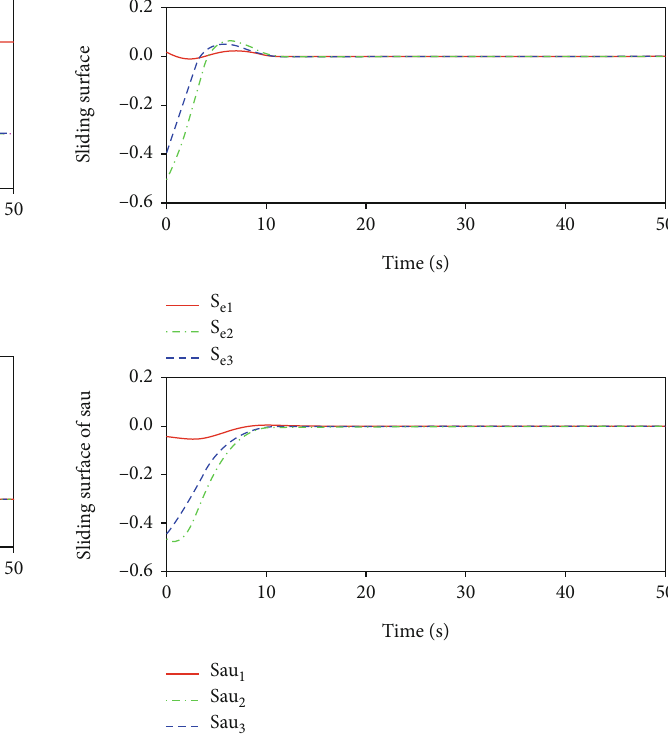
Figure 2: Time response of sliding surface and saturation sliding surface.